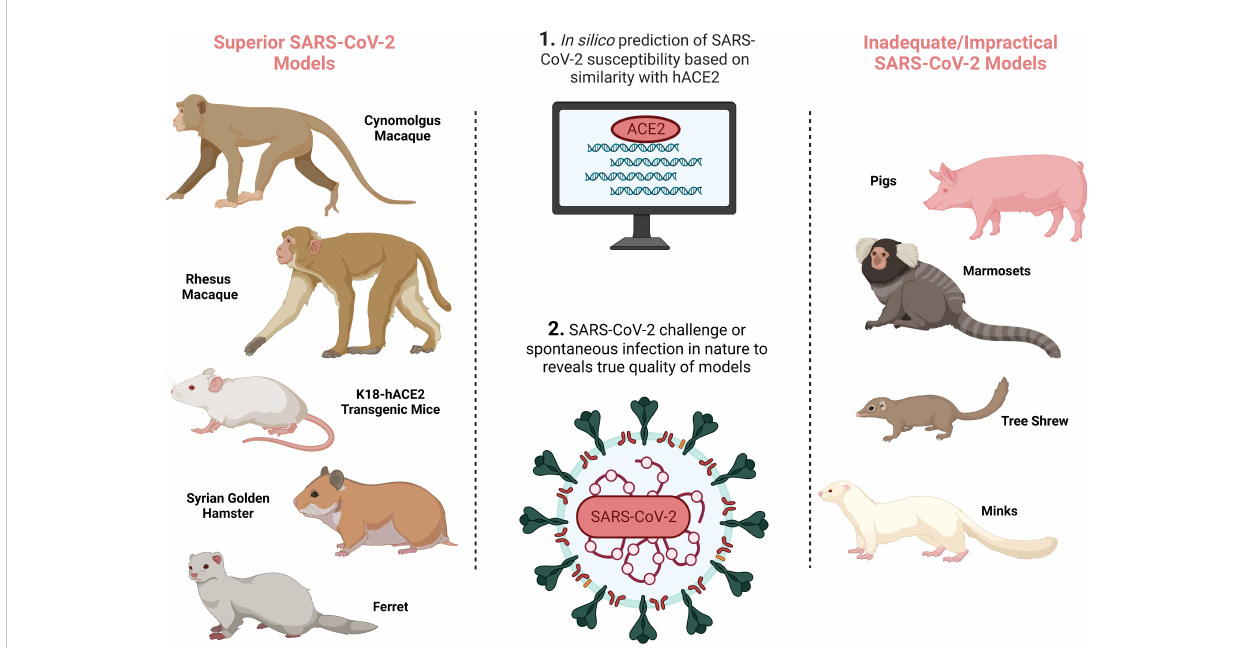
FIGURE 1 SARS-CoV-2 animal model development overview demonstrating the preferred SARS-CoV-2 animal models on the left, and inadequate/impractical COVID-19 models with de fi ned limitations on the right, and the processes by which animal models are identi fi ed in the central column. Created with